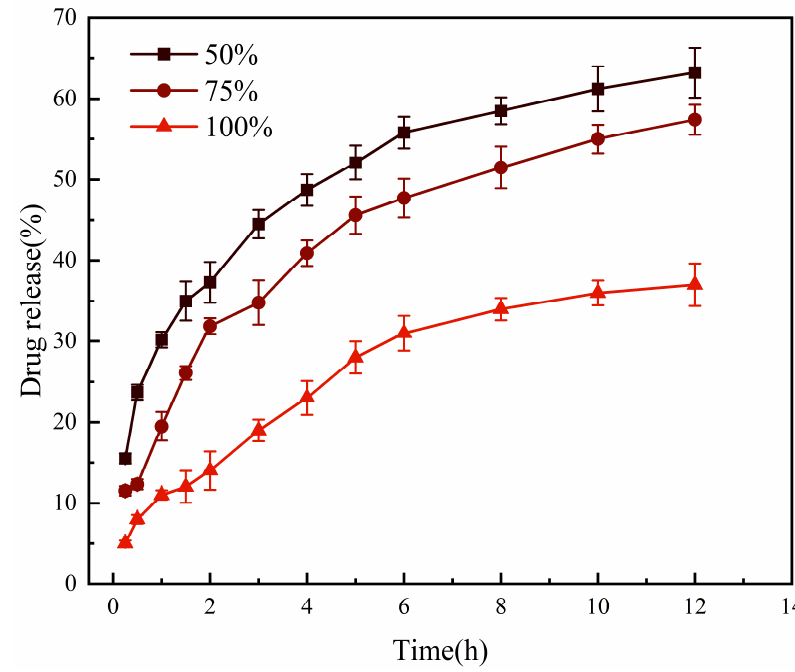
Figure 11. Drug release profiles of the tablets printed with various infill densities.